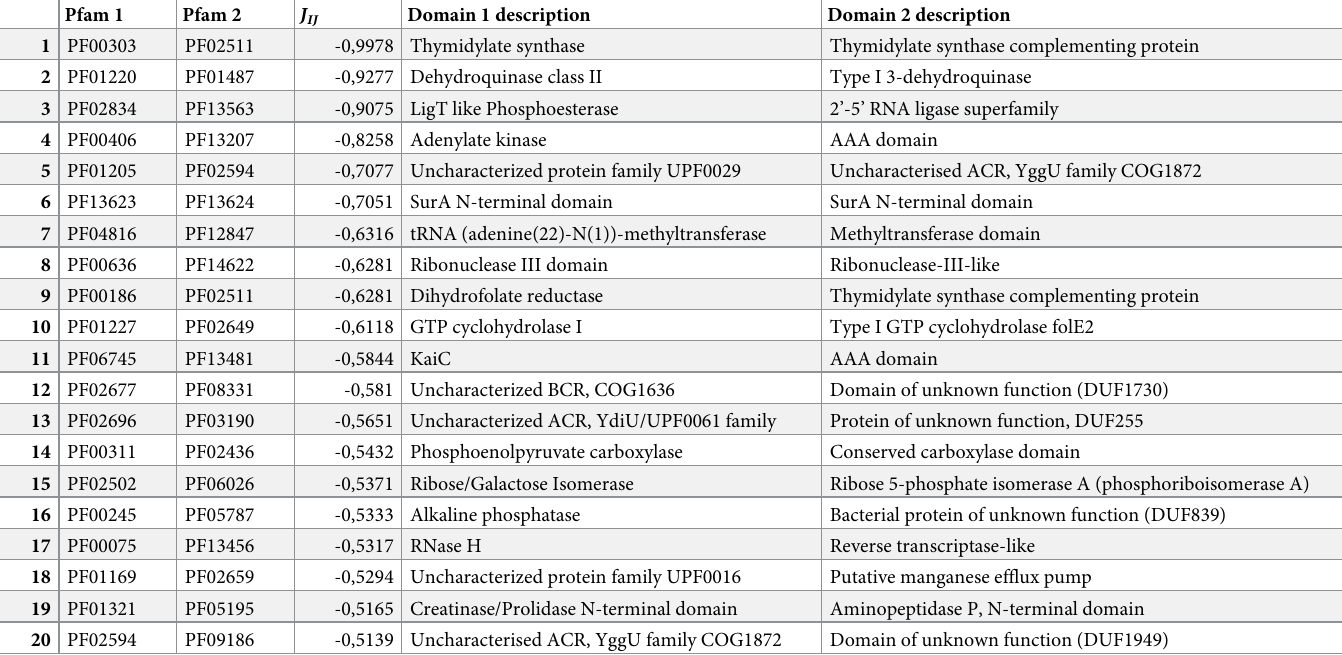
Table 2. The 20 domain pairs of top negative phyletic